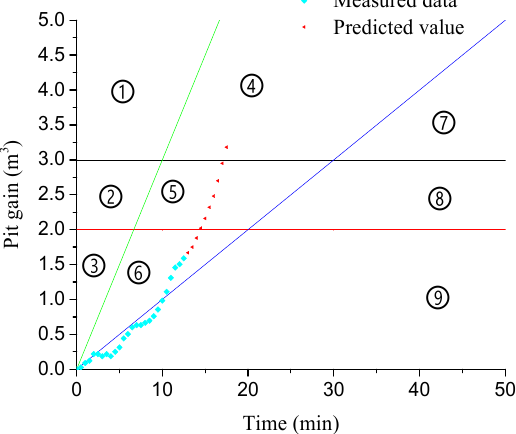
Figure 10. Kick severity analysis result using forecasted pit gain.